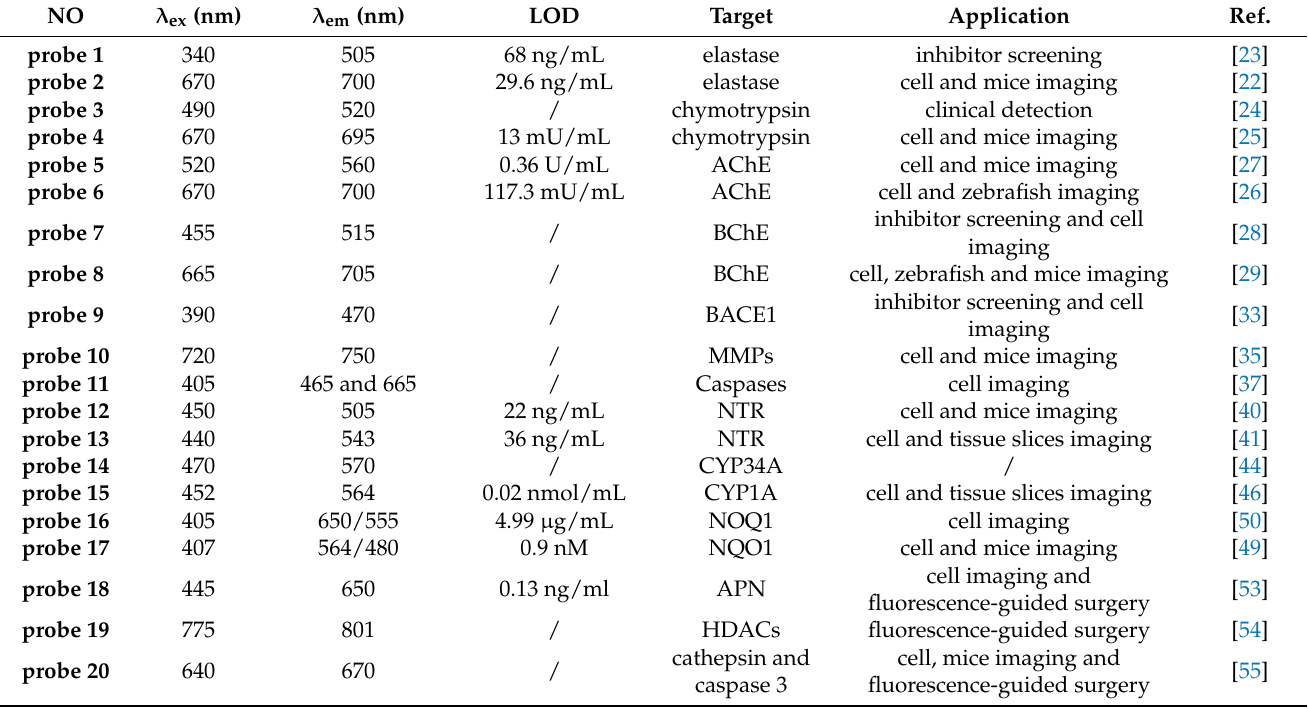
Table 1. The basic information of listed probes in the main text.